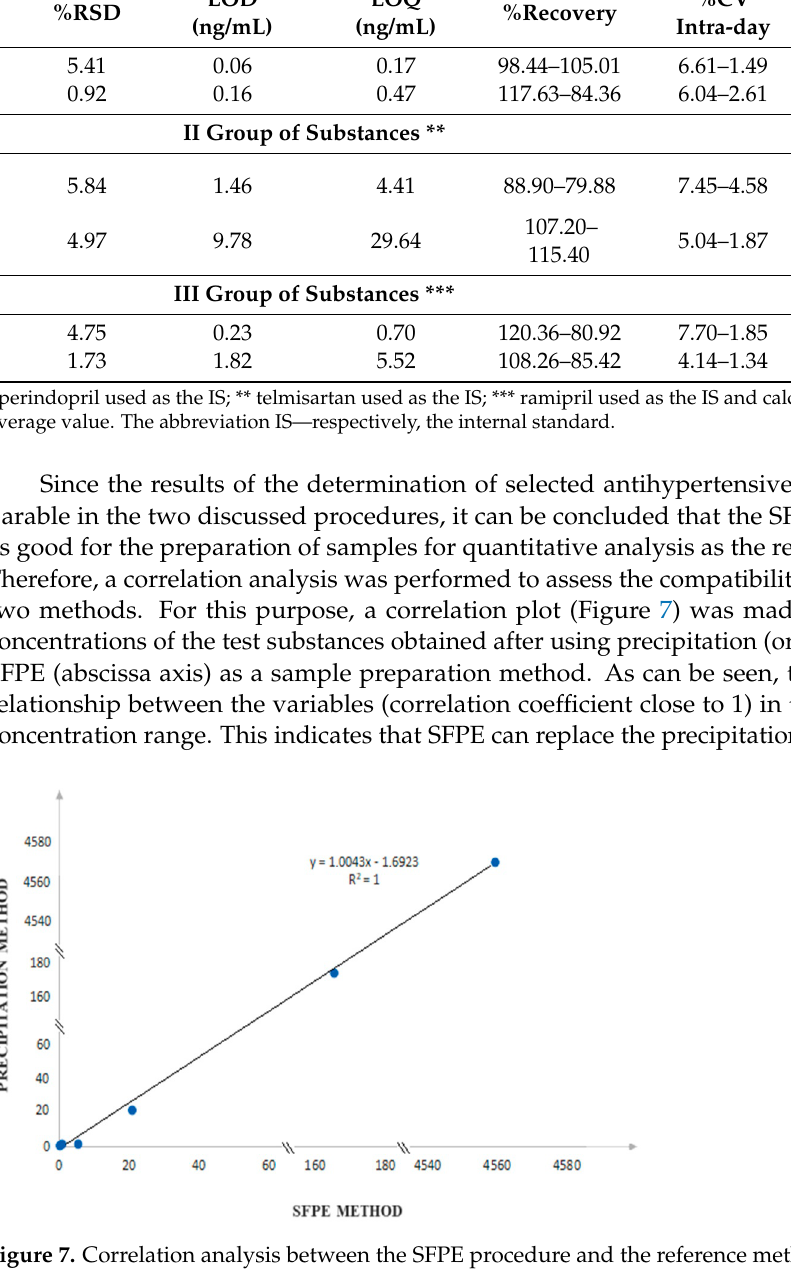
Figure 7. Correlation analysis between the SFPE procedure and the reference method.